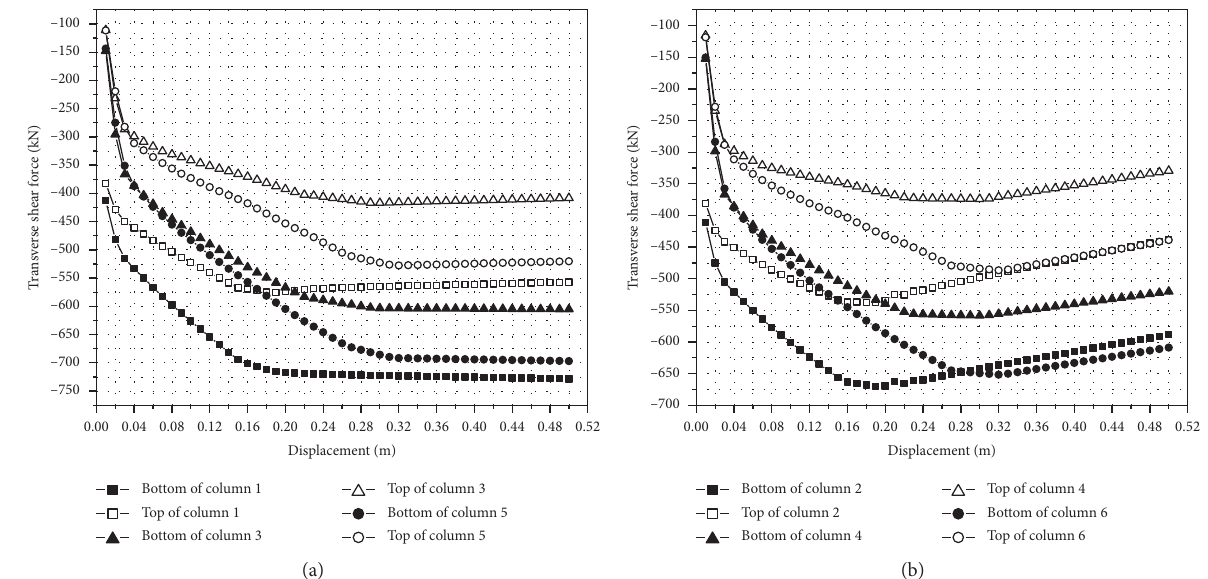
Figure 33: Transverse shear force-displacement at the top and bottom of the piers. (a) Transverse shear force-displacement at the top and bottom of the piers at the upstream side. (b) Transverse shear force-displacement at the top and bottom of the piers at the downstream side.